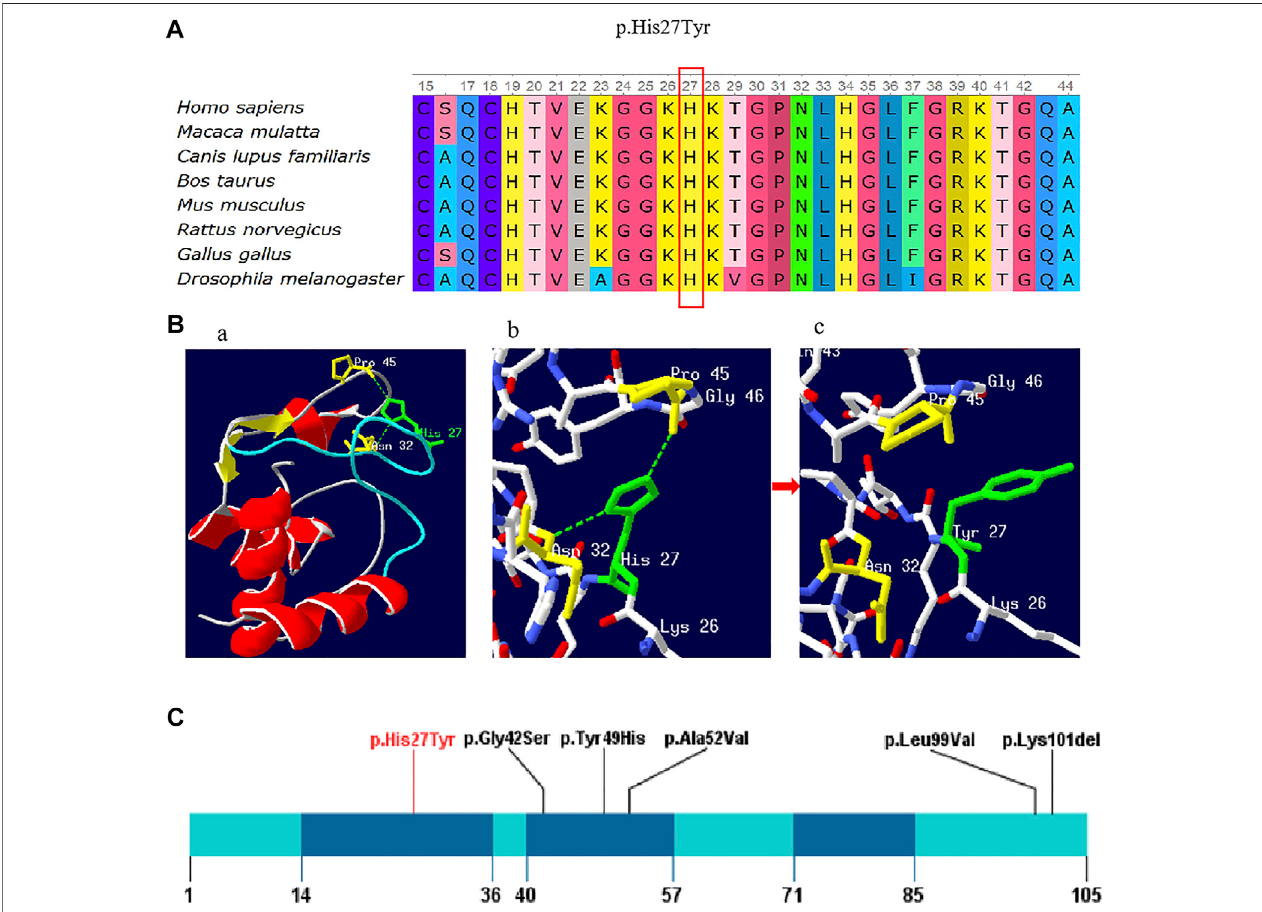
FIGURE2 |(A) Conservation ofthe p.His27Tyr variant acrossvarious species. (B) Amino acidand conformation changes ofthep.His27Tyrpolypeptide wild-type and mutant type. His27 is located in the random coil domain of CYCS by colored green (Ba) ; Stick models shows the amino acids around His27 and the selected side chains, wild-type His27 forms a hydrogen bond (green dotted line) with Asn32 and Pro45 (colored yellow) respectively (Bb) , and the hydrogen bond was lost in mutant typeTyr27 (Bc) . (C) SchematicpresentationoflinearCYCSprotein(NM_018947.6)withallvariants,redfontindicatereportedvariantinthepresentstudy.Thedark blue indicates three Ω